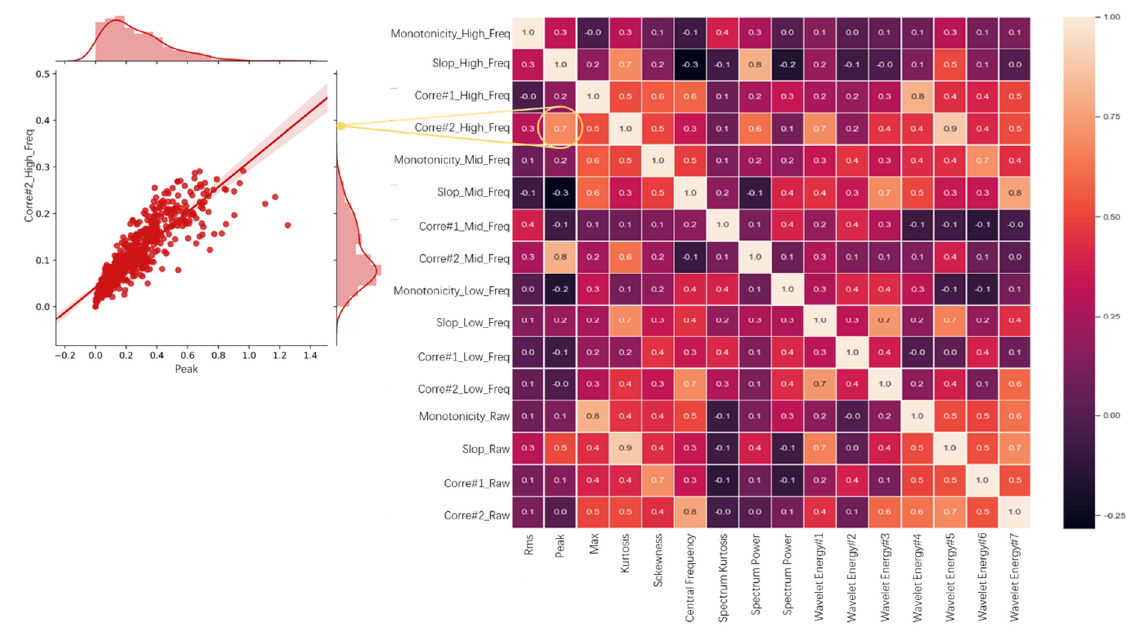
Figure 16. Correlations between elements in the ball screw dataset.